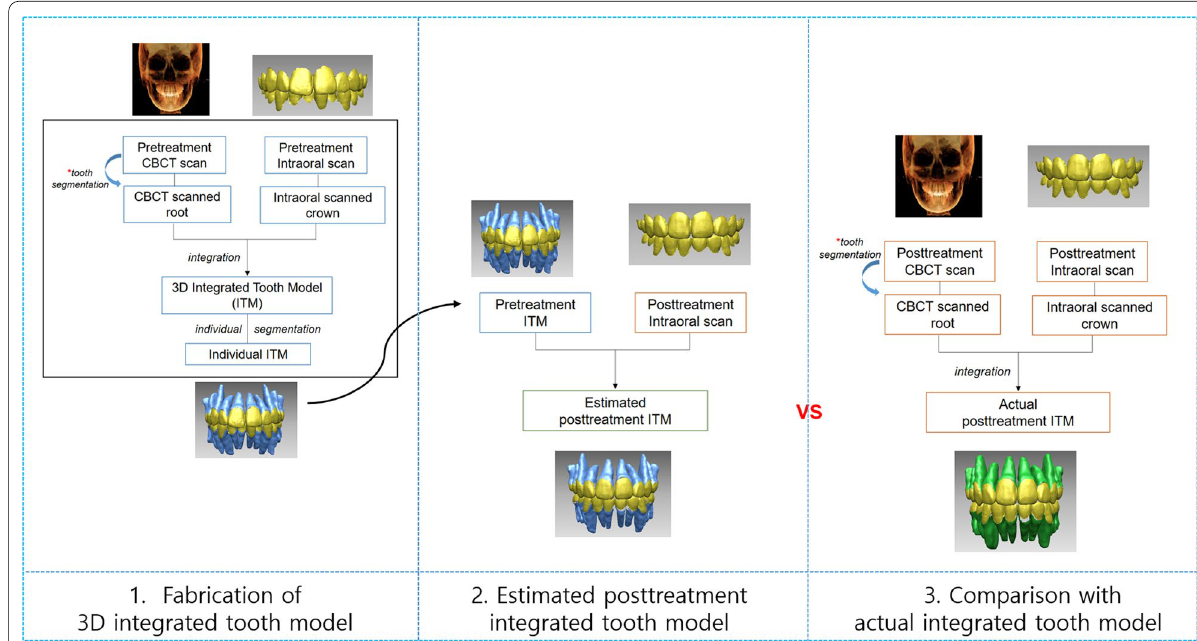
Fig. 1 Application scenarios for this study. 3D integrated tooth model was fabricated by merging pretreatment CBCT scan and pretreatment intraoral scans. The fabricated pretreatment integrated tooth model was registered onto the posttreatment intraoral scans and resulting estimated posttreatment tooth model was compared to actual posttreatment tooth